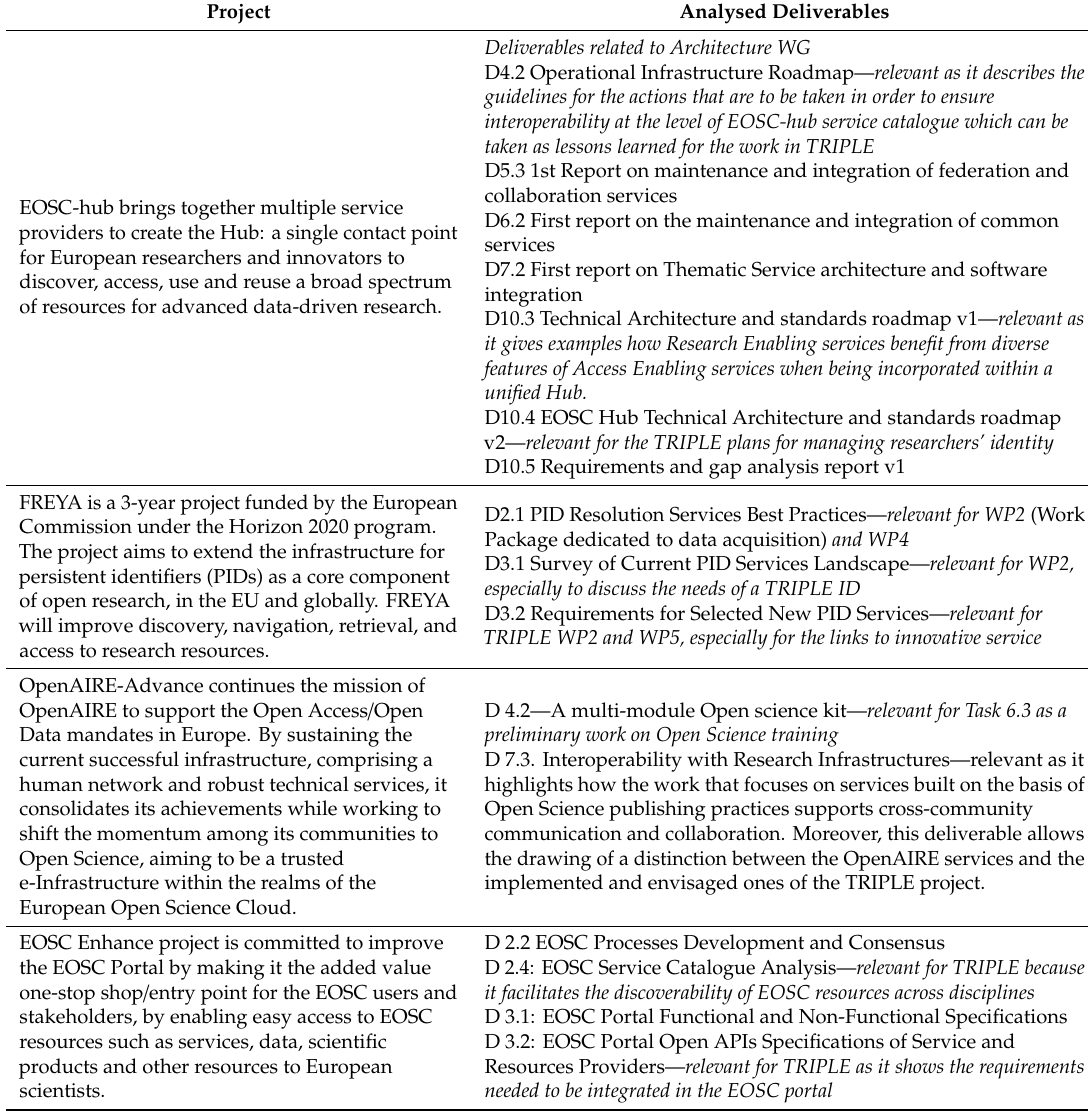
Table 5 o ff ers the highlights of 15 deliverables from four projects, particularly relevant for TRIPLE. Table 5. Mapping EOSC-related projects and relevant